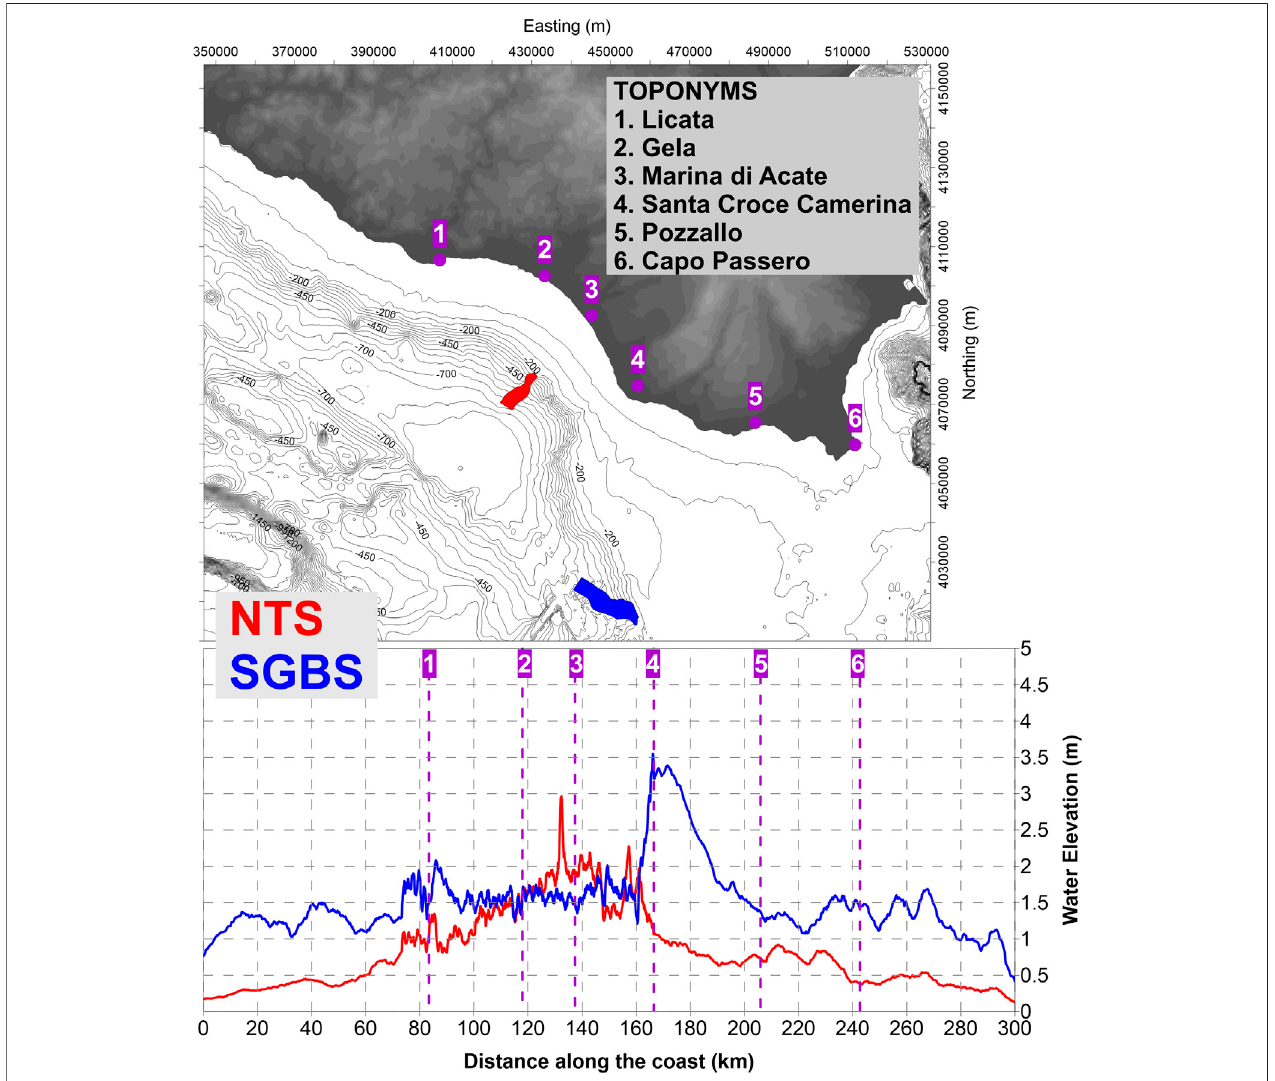
FIGURE 9| (Upper panel) Map ofthe Sicily coast, with relevant coastal cities. The red and blue spots represent the NTS and SGBS, respectively. (Lower panel) Maximumwaterheightassociatedwiththetwotsunamiscenarios(NTSandSGBS,inredandbluerespectively)alongthecoastofSicilyfromwesttoeast.Thenumbers and the dashed-purple lines refer to the toponyms reported in the upper